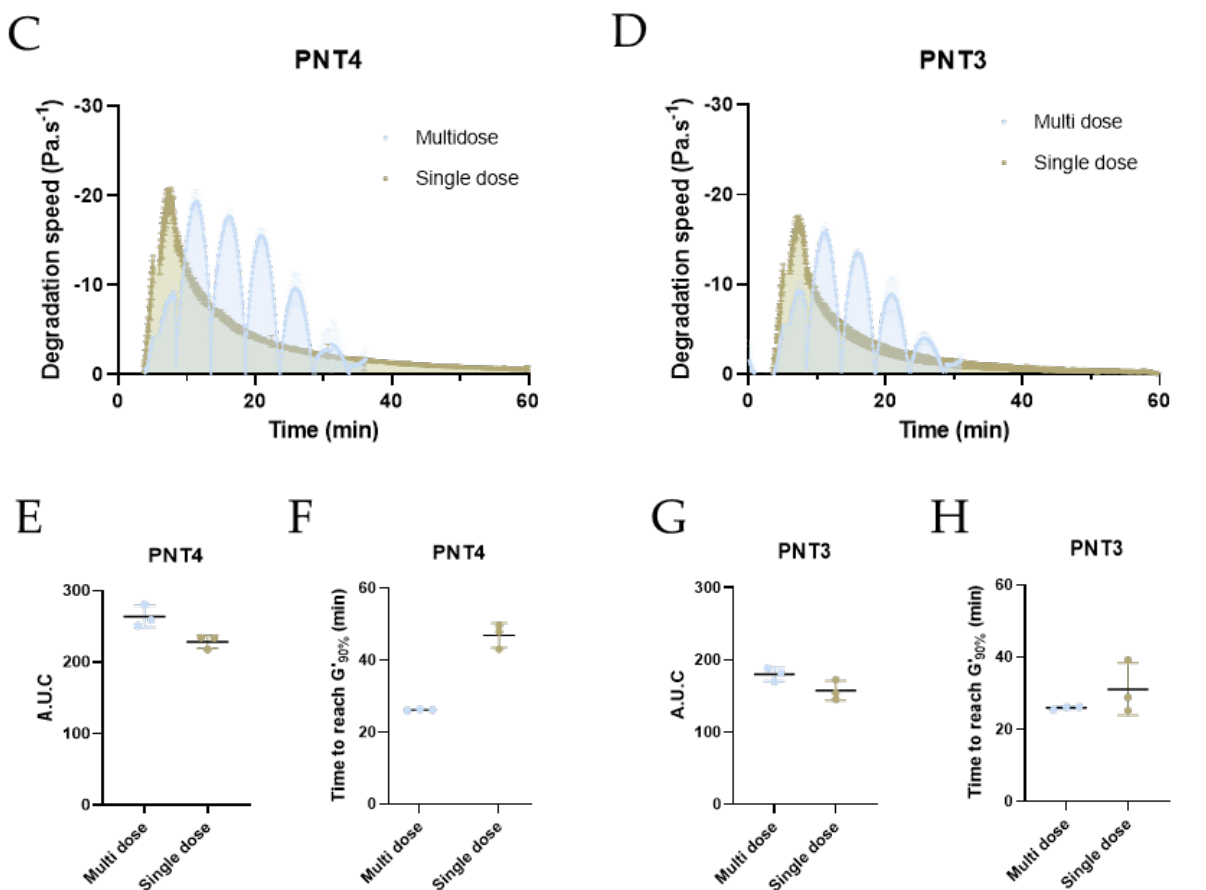
Figure 4. Optimization of PNT4 and PNT3 degradation by multiple injections of 38.3 U · mL − 1 Hylenex every 5 min, followed by rheological time sweeps. Evolution of the storage modulus of PNT4 ( A ) and PNT3 ( B ) gels over time, measured by time sweeps (37 ◦ C, strain 0.1%, 1 Hz) following single or multiple injections of the Hylenex enzyme (38.3 U · mL − 1 per injection, 5 min injection span for multidose), total volume and enzymatic units were equivalent to single and multidose. Dotted lines represent 10% of initial G’, First derivative curves of PNT4 ( C ) and PNT3 ( D ) gels for single and multidose injections, area under the curve of PNT4 ( E ) and PNT3 ( G ) gels calculated from the first derivative curves, time required to reach 90% of gel degradation for PNT4 ( F ) and PNT3 ( H ) gels, relative to the initial storage modulus. All results are presented as mean ± S.D, n =